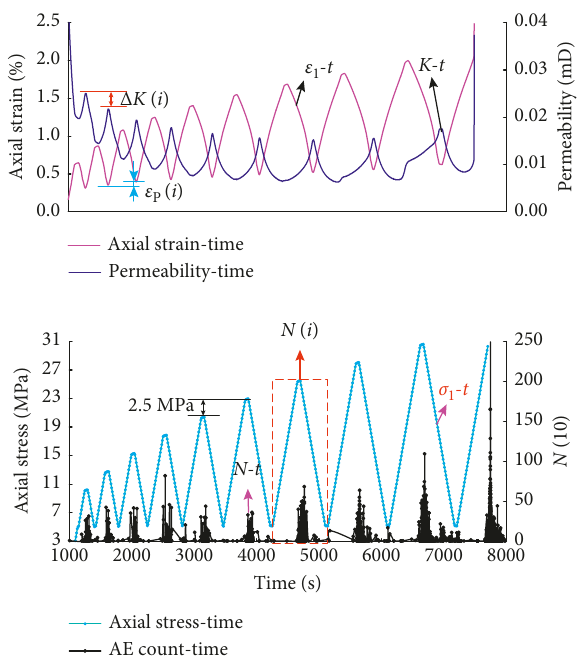
Figure 4: The corresponding relationship diagram of stress-strain, permeability, and AE of RC-1.